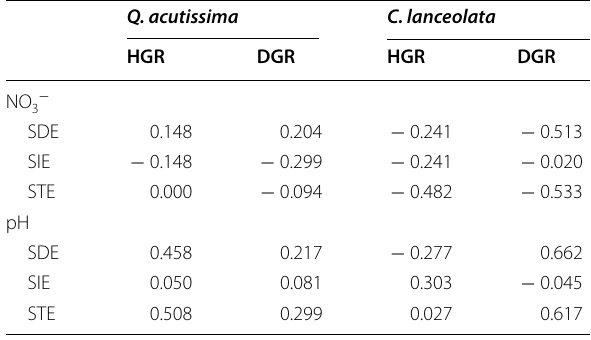
This table shows the standardized direct, indirect, and total effects of the concentration of NO 3 − in AR and AR pH on the height and basal diameter growth rates of Q. acutissima and C. lanceolata saplings pH, AR pH; NO 3 − , the concentration of NO 3 − in AR; HGR, height grow rate; DGR, basal diameter growth rate; SDE, standardized direct effects; SID, standardized indirect effects; STE, standardized total